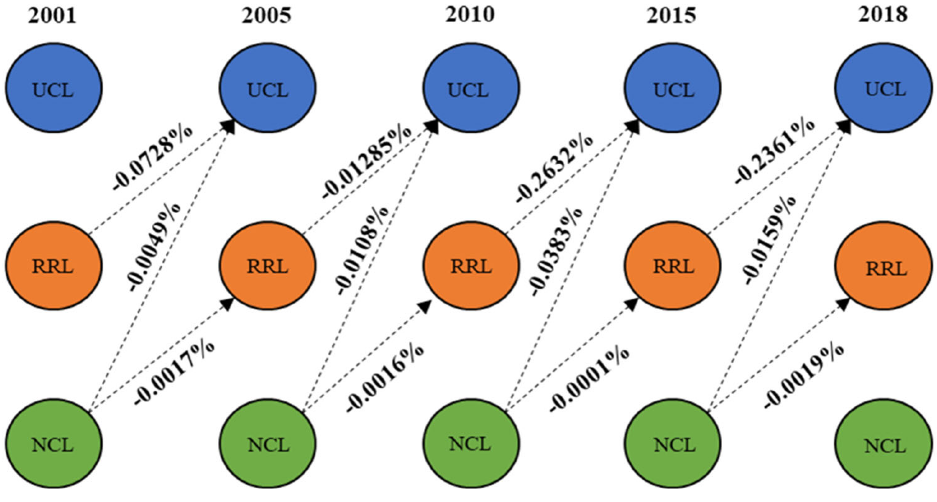
Figure 7. The CCD losses during land transitions.